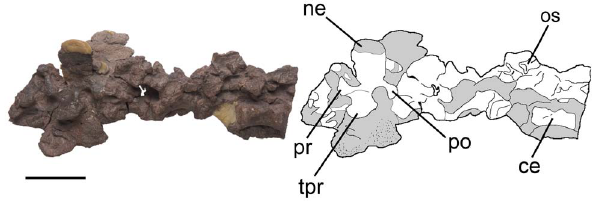
Figure 7. Posterior dorsal vertebrae of Pseudochampsa ischigualastensis (PVSJ 567) in dorsolateral view. Abbreviations: ce, centrum; ne, neural spine; os, osteoderm; po, postzygapophysis; pr, prezygapophysis; tpr, transverse process. Scale bar equals 3